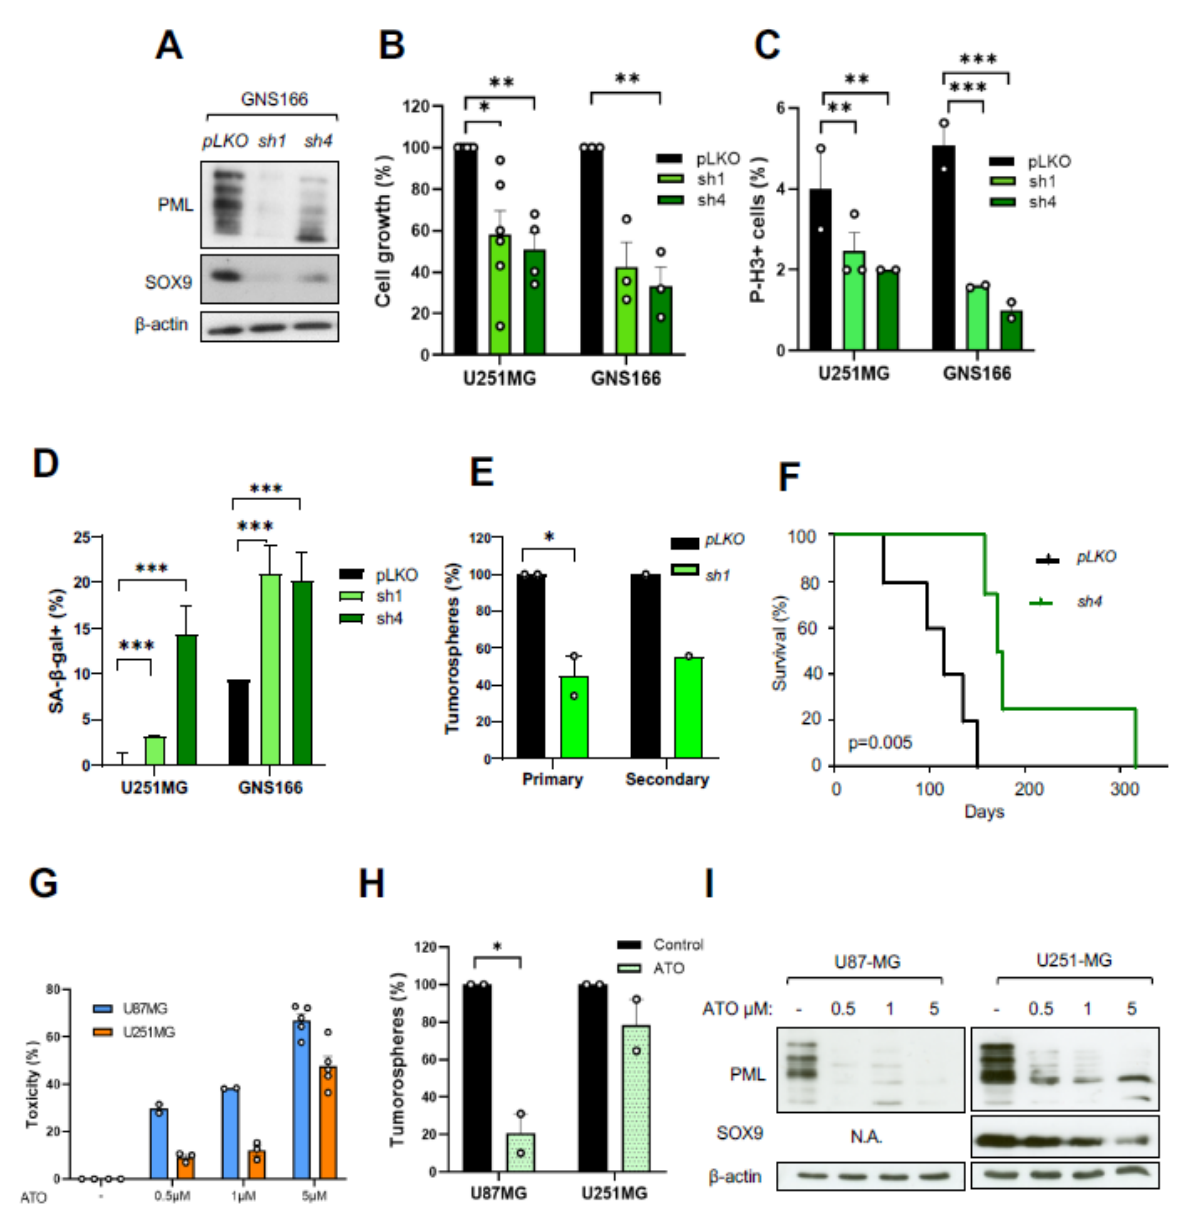
Figure 6. Genetic and pharmacological PML inhibition in glioma cells: ( A ) representative immunoblot of PML and SOX9 expression in sh1 and sh4 PML knockdown and pLKO control GNS166 cells ( n = 3); ( B ) quantification of cell growth in control and PML knockdown cells ( n = 3); ( C ) quantification of P-H3 + in control and PML knockdown ( n = 3); ( D ) quantification of SA- β -gal + cells in control and PML knockdown ( n = 3); ( E ) quantification of primary and secondary tumorspheres in PML knockdown U251-MG cells. Quantifications are relative to pLKO conditions; ( F ) Kaplan–Meier curves of mice after stereotactic injection of GNS166 control cells ( n = 5) and shPML-4 cells ( n = 5); ( G ) cytotoxicity of indicated glioma cells after treatment with increasing doses of arsenic trioxide (ATO) for 48 h ( n = 5). Calculations were relative to untreated cells; ( H ) relative quantification of oncospheres after treatment with 1 µM ATO ( n = 2); ( I ) representative immunoblots of PML and SOX9 expression in glioma cells after treatment with 0.5, 1, and 5 µM ATO for 48 h ( n = 3). * p < 0.05, ** p < 0.01, *** p < 0.001 .